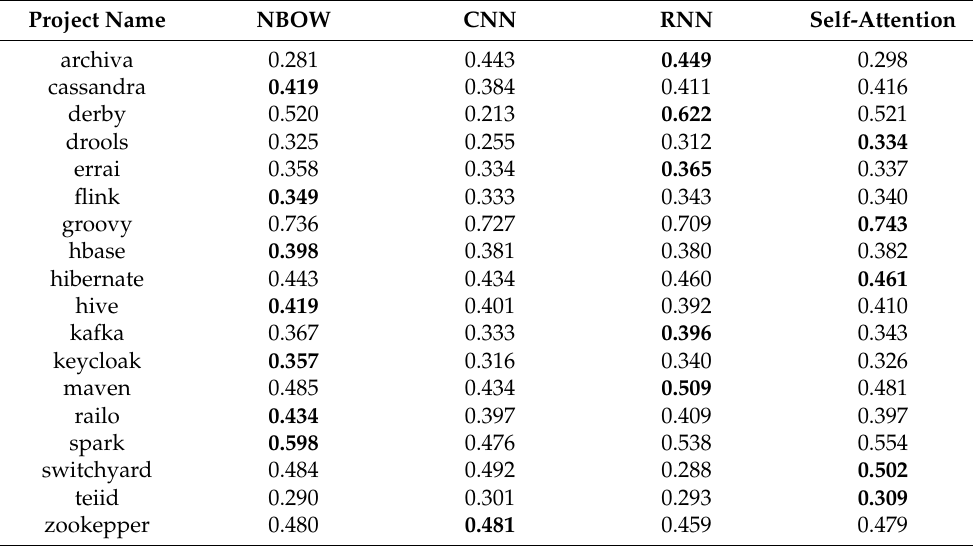
Table 4. Performance of 4 neural network models under Recall @10.